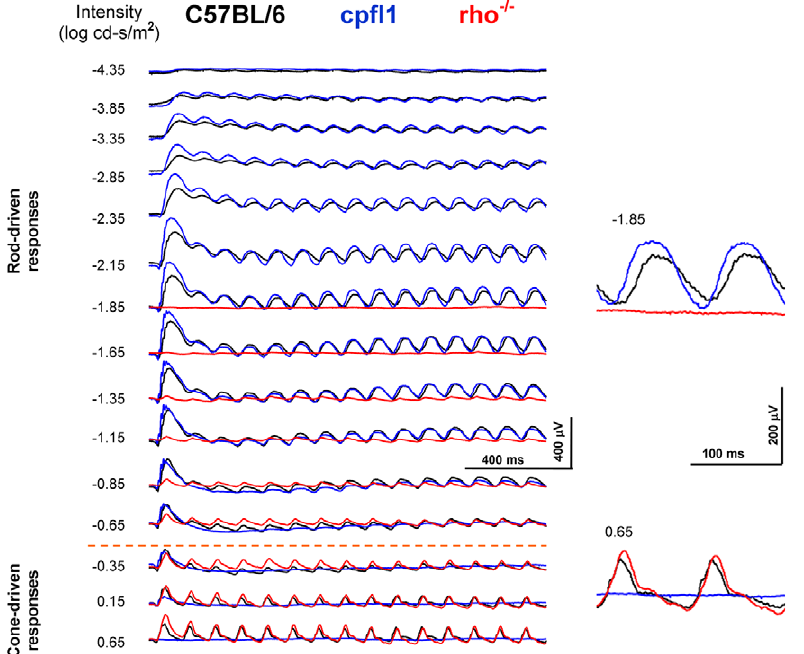
Figure 2. Dark-adapted10-Hz flicker ERGs elicited with a series of light intensity in C57BL/6 (in black), cpfl1 (in blue) and rho 2 / 2 (in red) mice. In the C57BL/6 mouse, flicker ERGs can be divided into two phases. The first phase is from 2 3.85 to 2 0.65 log cd-s/m 2 , the waveforms appear sine wave in shape and the latencies were longer. The second phase is from 2 0.35 to 0.65 log cd-s/m 2 , the waveforms appear triangular wave and the latencies are shorter. In the cpfl1 mouse, the responses of the first phase still exist, while the second phase responses are absent. In the rho 2 / 2 mouse, the first phase responses are absent, but the second phase responses remain. The results indicate that the first phase responses are rod- driven and the second phase responses are cone-driven. The dotted line indicates the light intensity break point where the flicker responses switch from rod-dominant to cone-dominant.